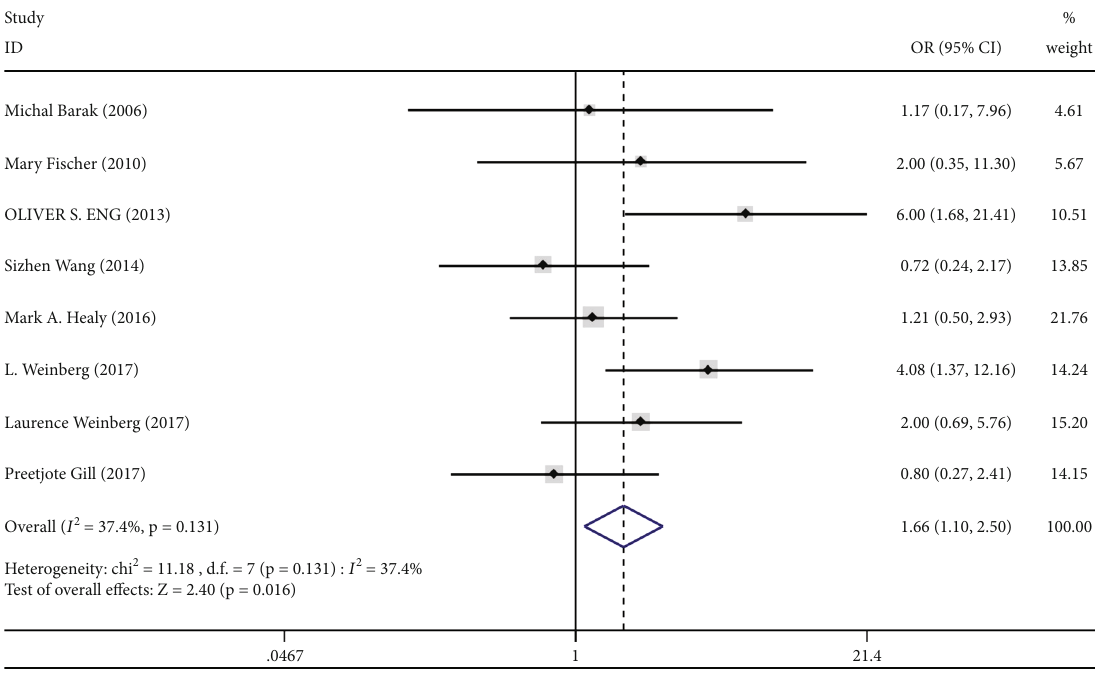
Figure 5: Forest plot for pulmonary complications.